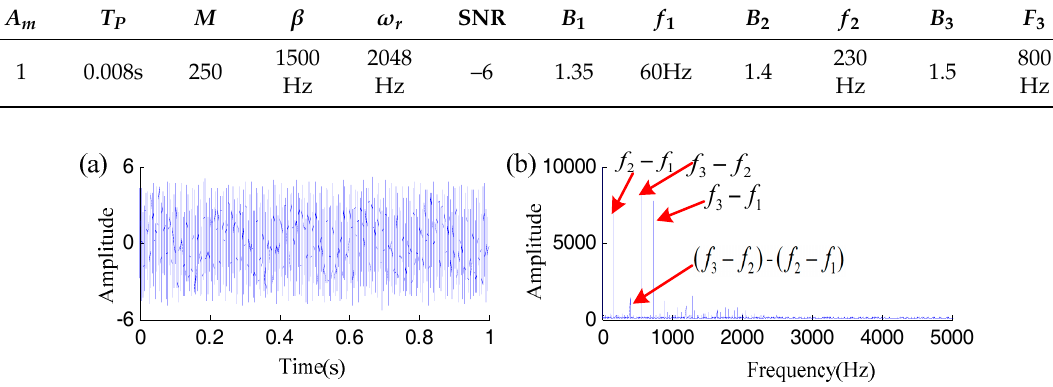
Figure 3. Simulated signal (with noise and interference) and its Hilbert demodulation spectrum. ( a ) The waveform of the simulted signal in the time-domain. ( b ) The Hilbert demodulation spectrum of the simulted signal The 2-row Hankerl matrixes were constructed for the simulation signal and their periodic impact, noise, and resonance components are denoted as H, H s , H n , and H h , respectively. The result